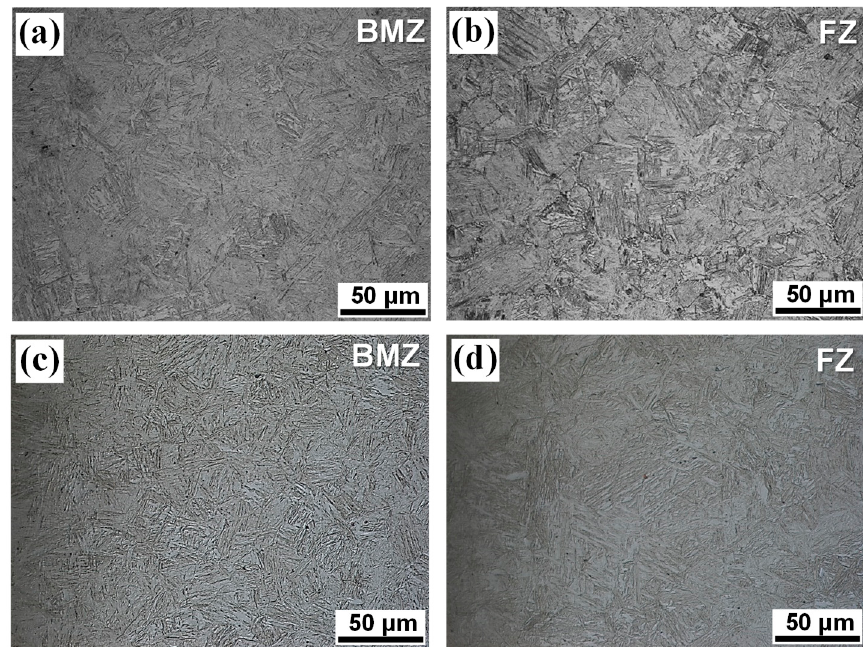
Figure 11. Microstructures of laser-arc hybrid weld joints after the tempering time of 2 h: ( a , b ) Type-I and ( c , d ) Type-II.